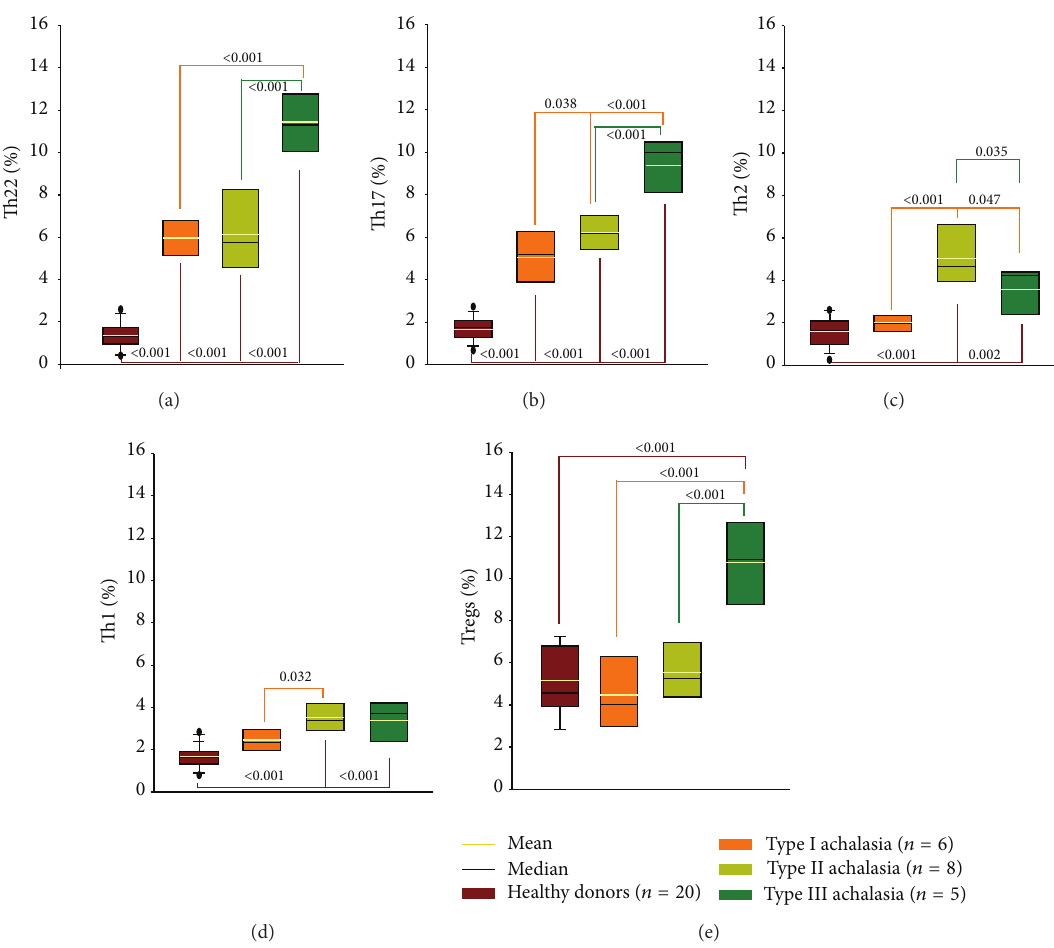
Figure5:CirculatingCD4 + T-cellsubsetsinachalasia.Relativepercentageofcirculating(a)Th22,(b)Th17,(c)Th2,(d)Th1,and(e)regulatory T cells. Results are expressed as mean (yellow line), median (black line), and 5th/95th percentiles of T